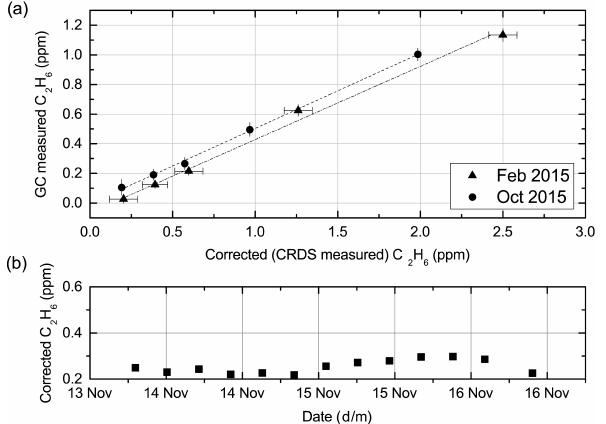
Figure 8. During a dilution sequence of ambient gas with C 2 H 6 , the CH 4 concentration decreases from its nominal concentration 1948.7ppb ± 0.32 ,ppb as the contribution from C 2 H 6 is increased. Thus both 12 CH 4 and 13 CH 4 undergo a similar decrease as the gas is diluted. However, what is observed is an increase in the reported value of 13 CH 4 , suggesting C 2 H 6 interference. The 12 CH 4 axis is plotted to the left in light green, whereas the 13 CH 4 axis is plotted to the right in dark green at a different scale. Error bars represent the standard deviation, the 12 CH 4 markers are larger than their as- sociated error